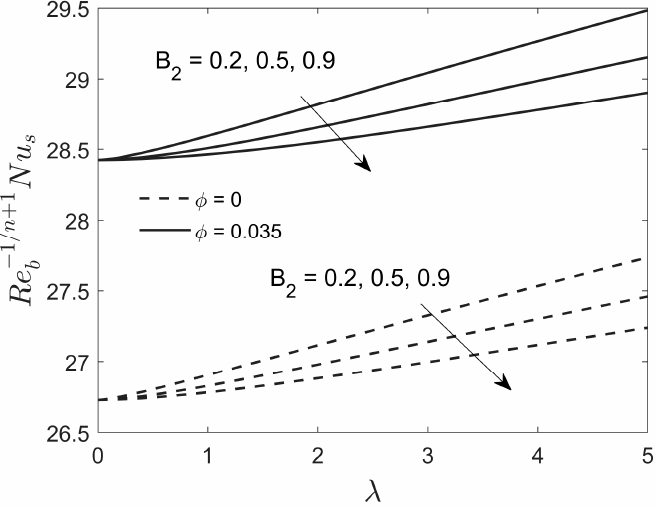
Figure 17. Effect of the slip on the Nusselt number against stretching/shrinking.